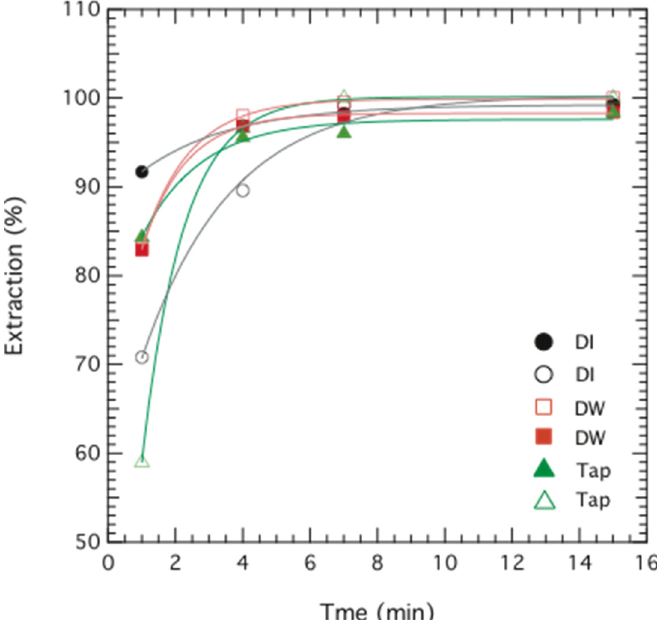
Figure 5. Extraction of chromium as a function of time. Data are plotted for two replicates of emulsion liquid membrane (ELM) formulations containing 2.5 wt% Span 80, 1 wt% Tween 80 and 0.35 wt% TOMAC prepared in de-ionized water (DI; ○ , ● ), distilled water (DW; □ , ■ ), and tap-water (Tap ▲ , ∆ ), respectively. The initial concentration of chromium was 114 ppm (DI), 95 ppm (DW) and 104 ppm